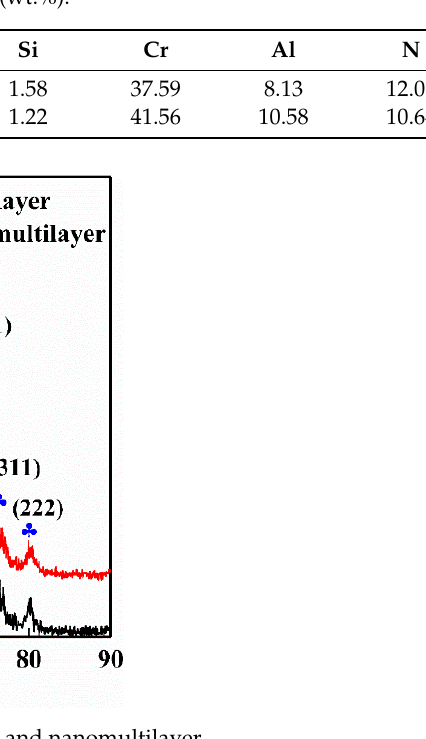
Figure 3. XRD patterns of CrAlN/TiSiN multilayer and nanomultilayer.